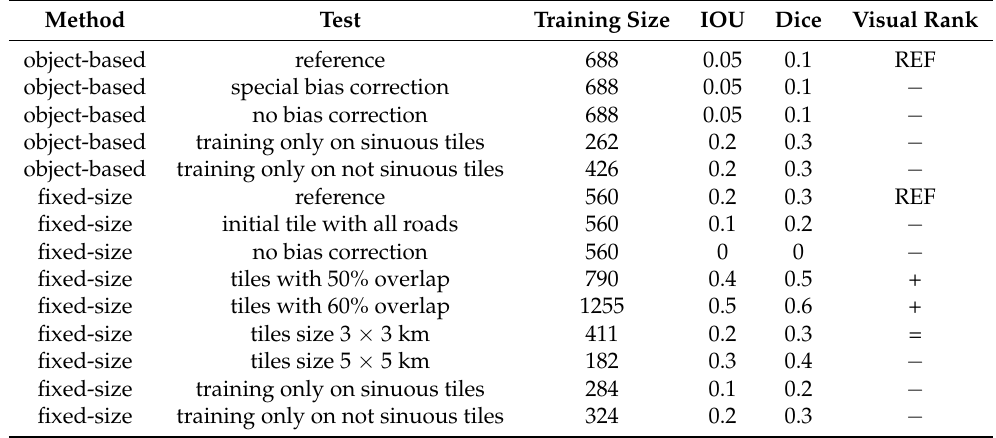
Table 2. Summary of main experiments and results on tiling